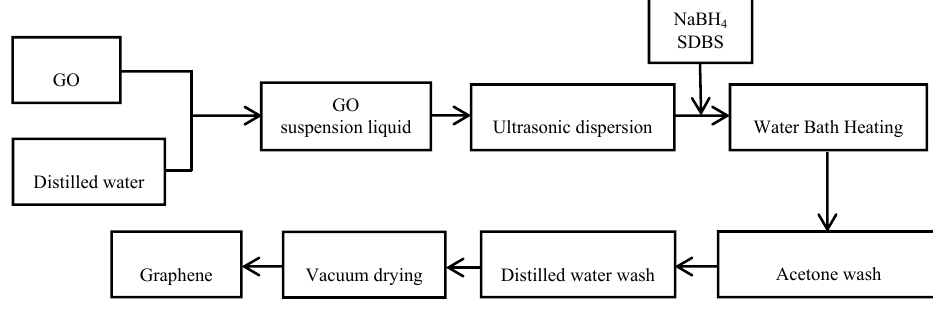
Figure 2. Flow chart of preparation of graphene by SDBS.